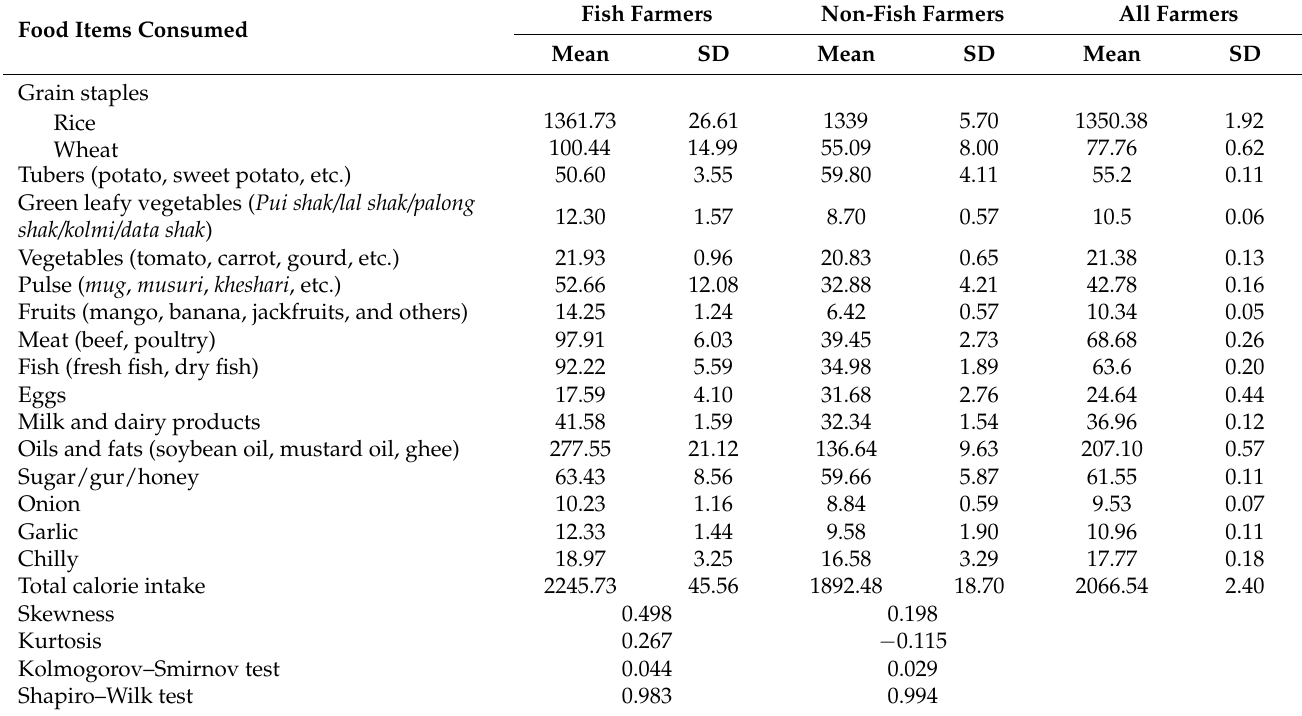
Table 6. Calorie intake of food items by fish and non-fish farm households